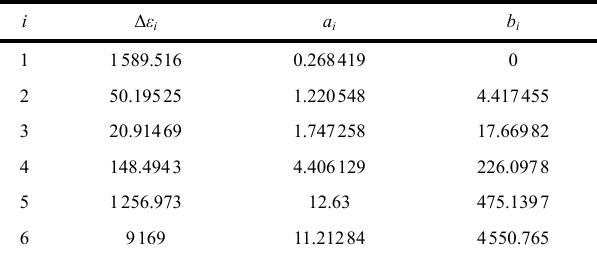
Table 2 Parameters of Au in Drude-Lorentz model.